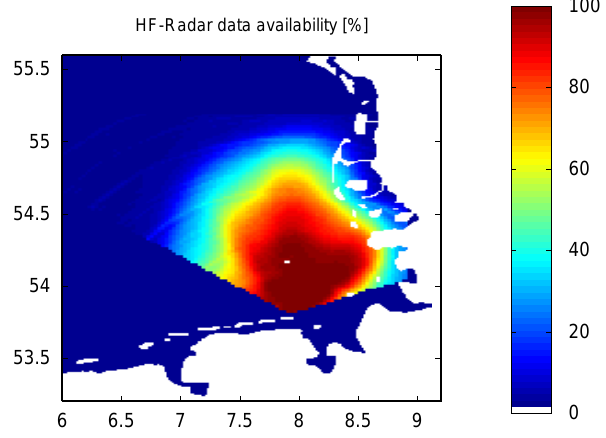
Fig. 5. HF radar array and data coverage. The colours illustrate the amount of valid data as percent of maximum number of records.